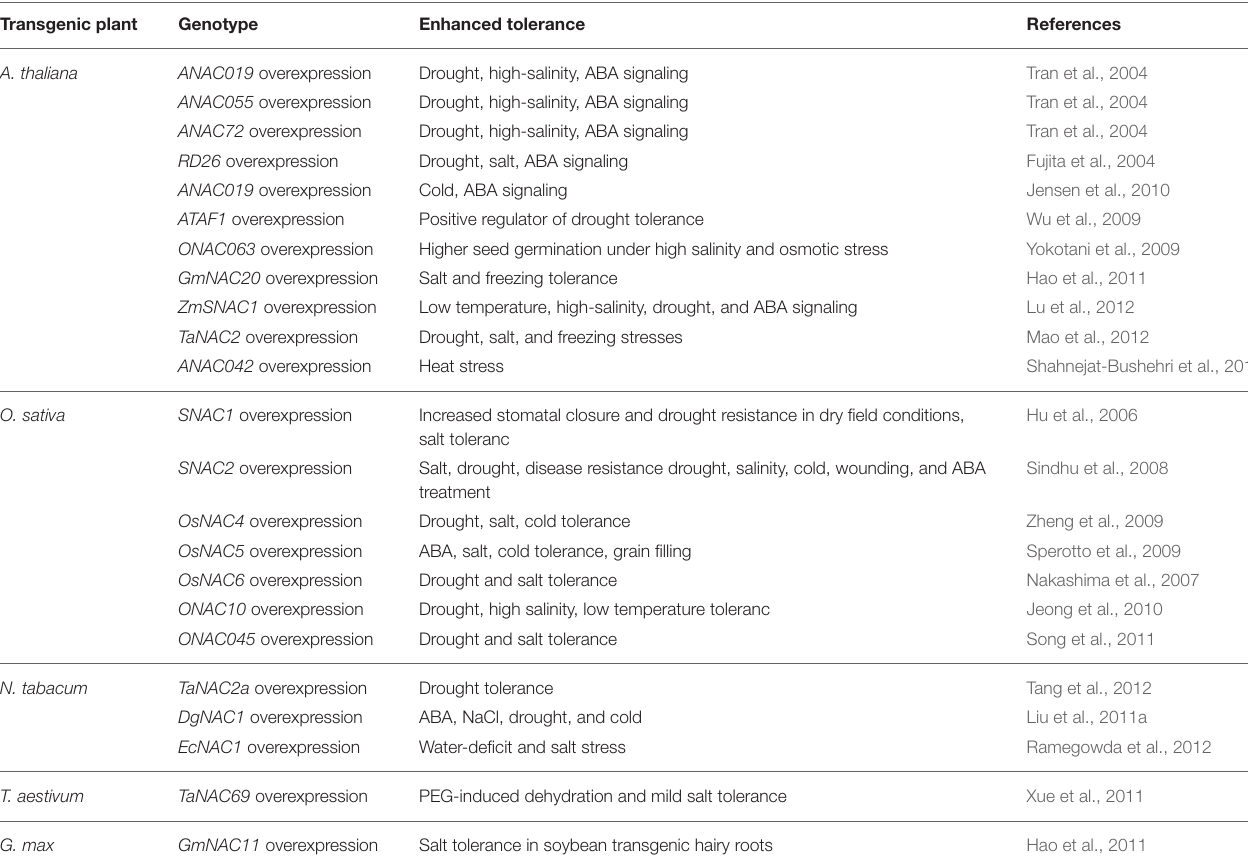
TABLE 2 | Abiotic stress tolerance of transgenic plant over-expressing NAC